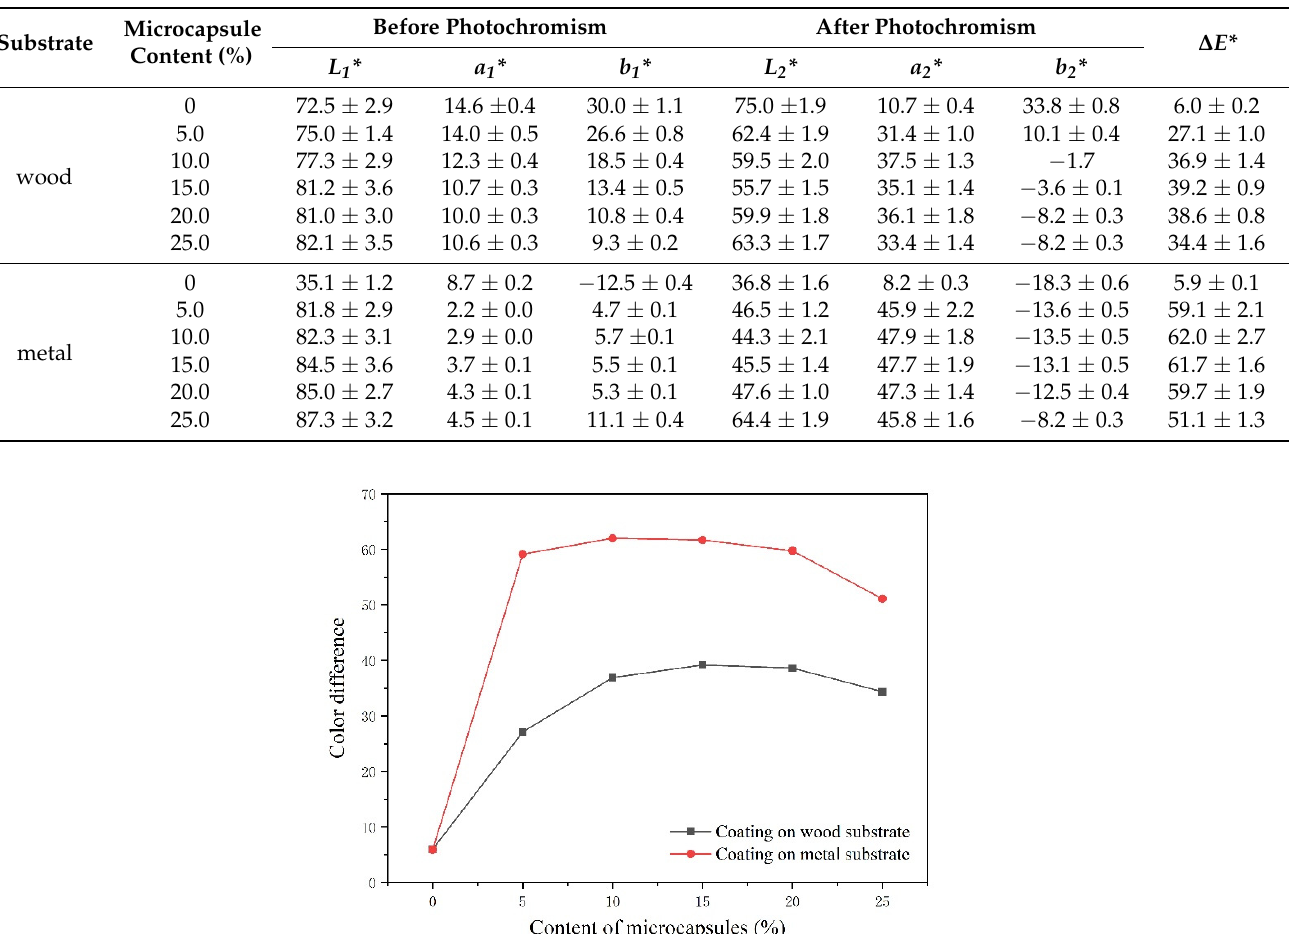
Table 7. Color difference data of the coatings before and after photochromism.